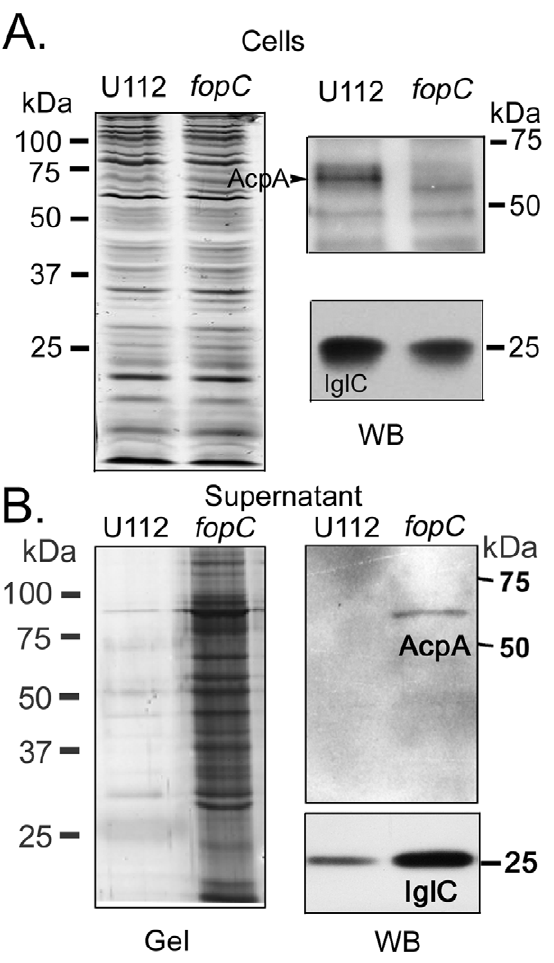
Figure 6. Biochemical characterization of fopC mutant pheno- type. Total proteins from similarly prepared cell pellets (A) and concentrated (60 fold) spent (36 h) culture supernatant (B) of U112 and fopC mutant strain were separated by 10% SDS-PAGE and either stained by silver reagents (Gel) or transferred onto a PVDF membrane and probed with anti-AcpA antibody or anti-IglC antibody (WB).